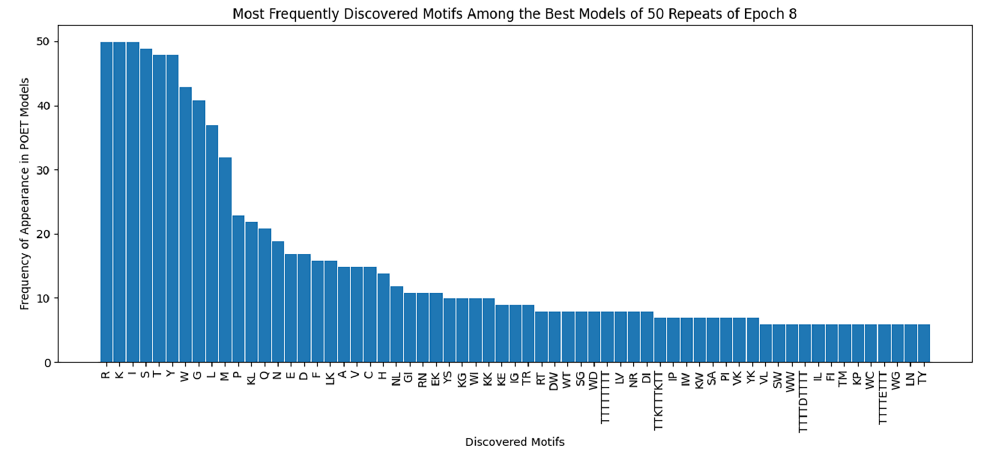
Figure 8 Frequency of discovered motifs in the best models of the 50 repeats of epoch 8. Due to the simplicity and the high number of data points only motifs are shown that are common between at least 10% of the models. Full-size DOI: